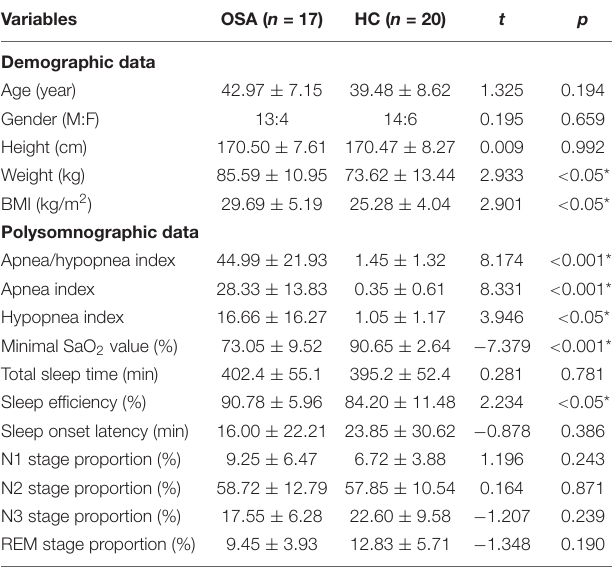
TABLE 1 | Baseline characteristics of the participants ( M ± SD